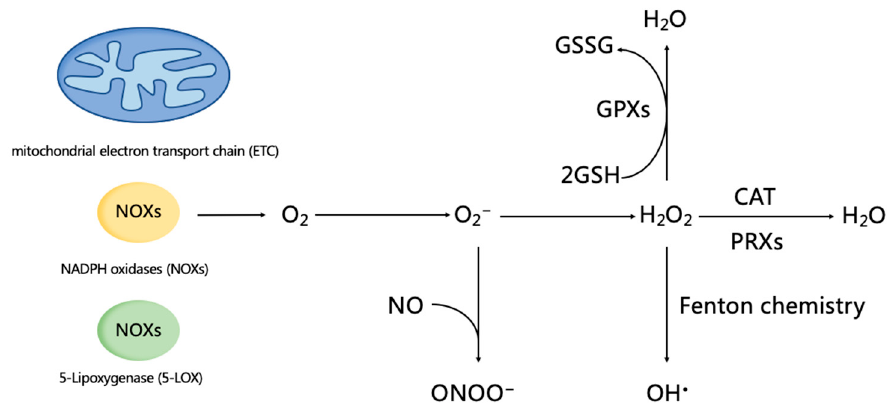
Figure 1. Reactive oxygen species (ROS) generation and homeostasis. The endogenous generation of ROS is primarily derived from the mitochondrial electron transport chain (ETC), including a family of membrane-bound NADPH oxidases (NOXs) and 5-Lipoxygenase (5-LOX). As a precursor of H 2 O 2 and OH • , O 2 − can be converted into H 2 O 2 by three isoforms of superoxide dismutases (SOD) (i.e., SOD1, 2, and 3) that locate in the cytoplasm, mitochondria matrix, and extracellular matrix. O 2 − reacts with nitric oxide (NO), and produces peroxynitrite (ONOO − ), which will decrease antioxidant capacity. OH • is the production of H 2 O 2 undergoing Fenton chemistry, and it owns the strongest chemistry activity, which can cause damage to biomolecules (such as DNA damage, lipid peroxidation, and protein denaturation). In addition, H 2 O 2 can be catalyzed to H 2 O by peroxiredoxins (PRXs), glutathione peroxidases (GPXs), and catalase (CAT). Glutathione (GSH) is the main non-enzymatic antioxidant in cells, and plays an important role in the degradation of H 2 O 2 . Two molecules of GSH are oxidized by H 2 O 2 through GPX, and are converted into glutathione disulfide (GSSG), and then are regenerated GSH via glutathione reductase (GR) and NADPH.